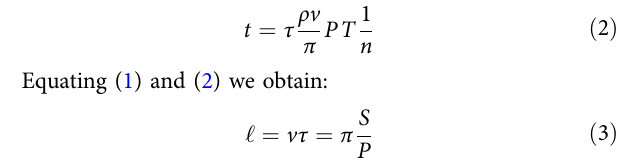
In Fig. 1c we report as solid circles the experimental values of the mean path lengths as a function of the number of obstacles. Experimental data closely match the predicted linear behavior in (Eq. 4) with an intercept fi xed at π S / P = π R /2 = 49.3 μ m and